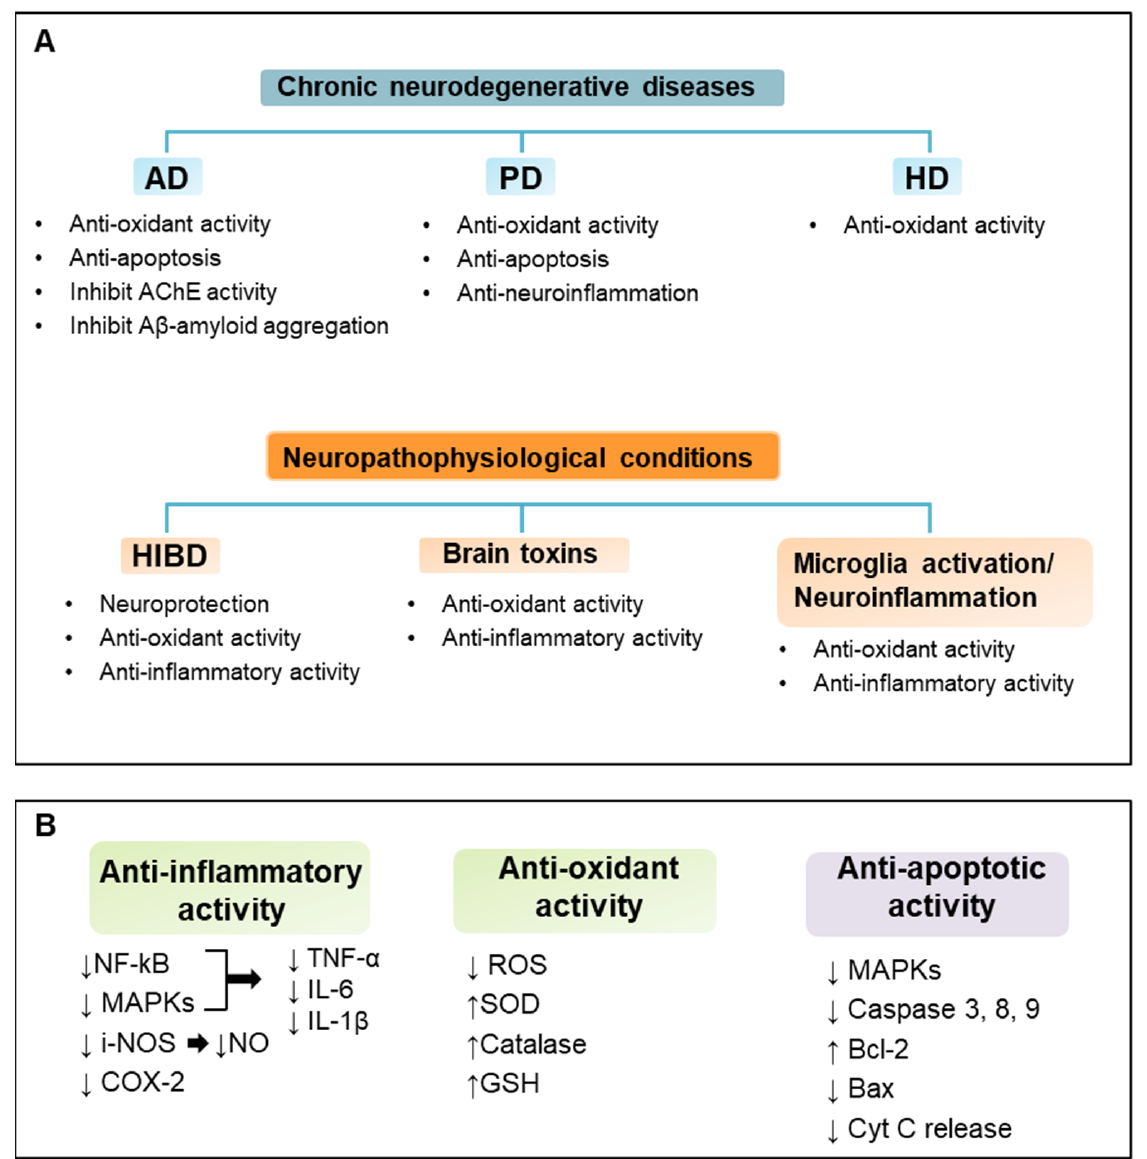
Figure 2. Neuroprotective effects and mechanisms of vanillin. Vanillin exerts multiple different pro ‐ tective effects on various neurological conditions. Main neuroprotective effects and mechanisms of vanillin on chronic neurodegenerative diseases and neuropathophysiological conditions are sum ‐ marized in panel ( A ). Molecular signaling pathways involved in vanillin anti ‐ inflammatory, anti ‐ oxidant, and anti ‐ apoptotic activity are outlined in panel ( B ).